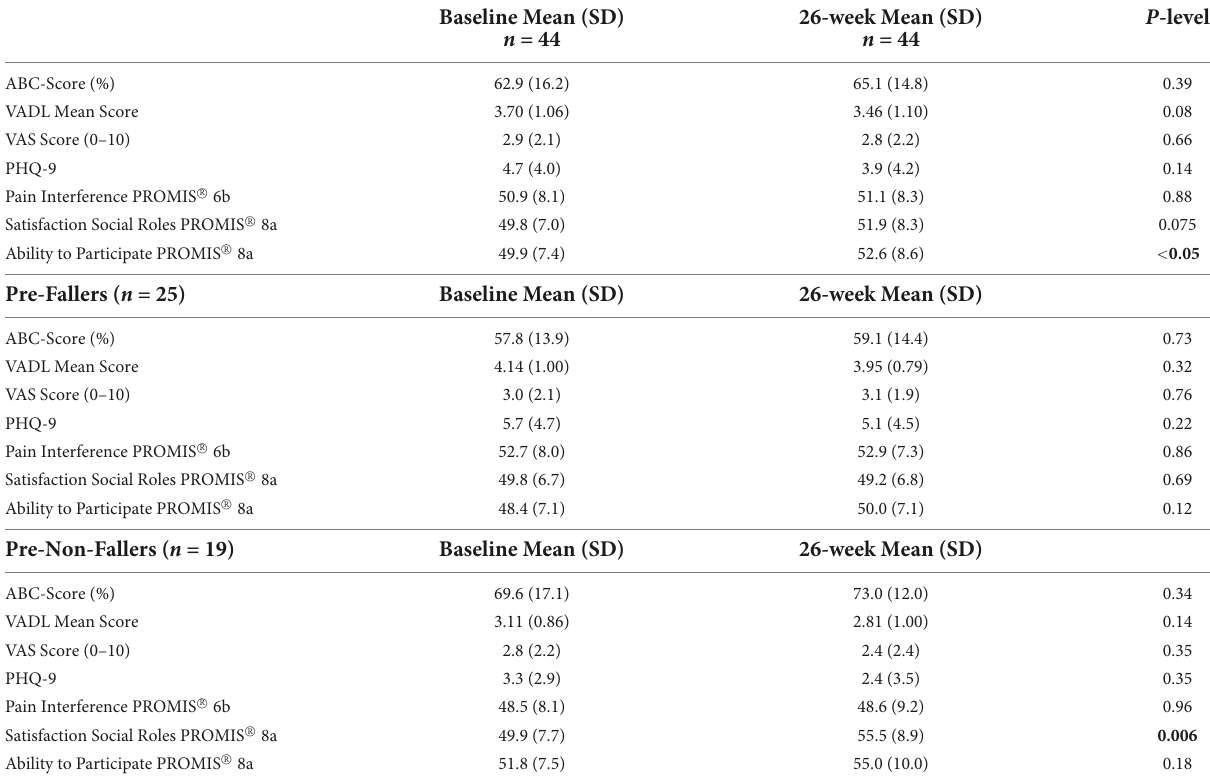
TABLE 4 Results from self-reported outcomes for the 44 individuals who completed all